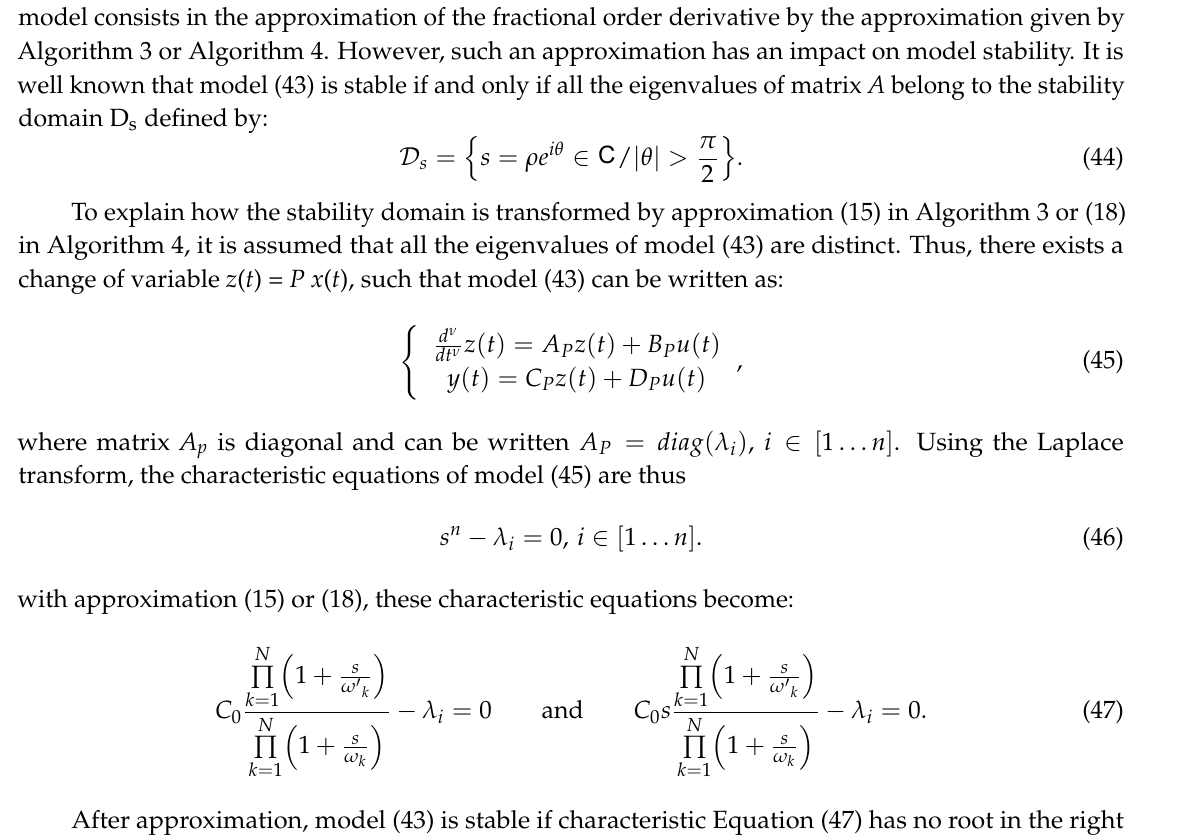
Figure 8. Comparison of relative ( left ) and absolute ( right ) errors between Algorithms 1 and 5 with distribution D 3 .